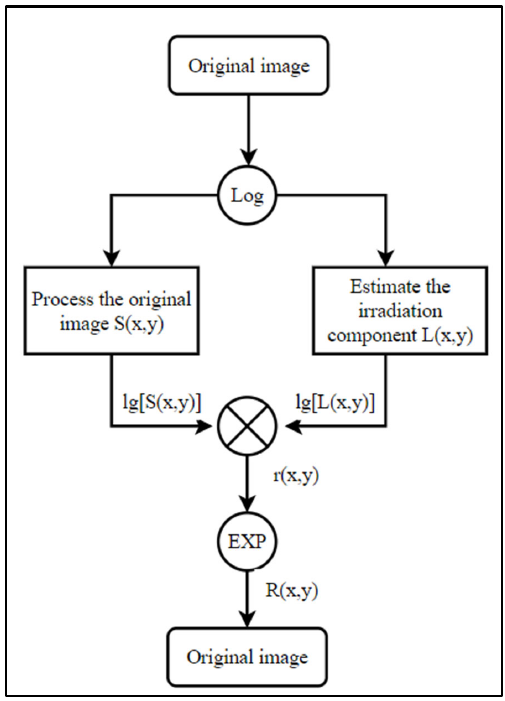
Figure 3. Processing flow of the Retinex algorithm.